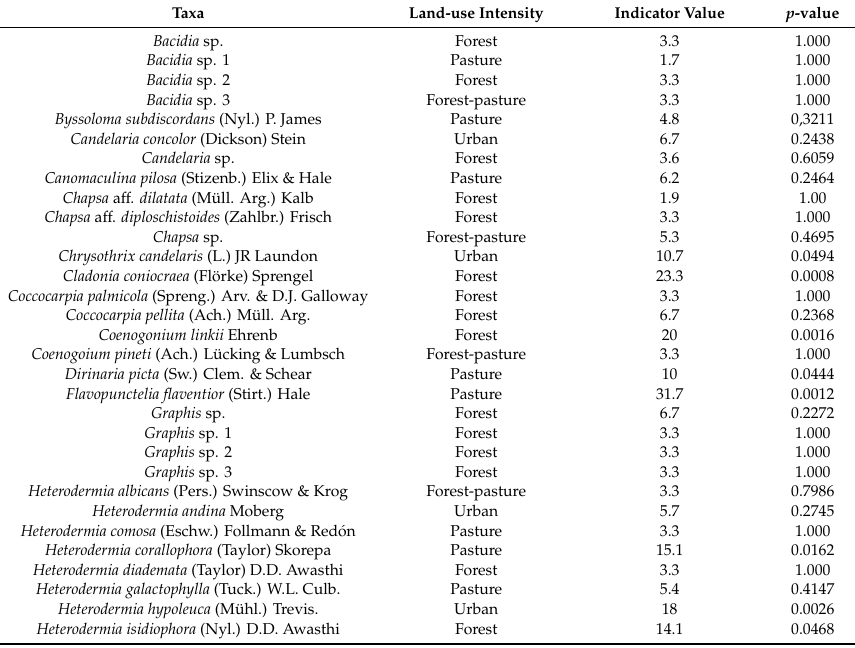
Table A1. Indicator species analysis found in forest, forest-pasture, pasture and